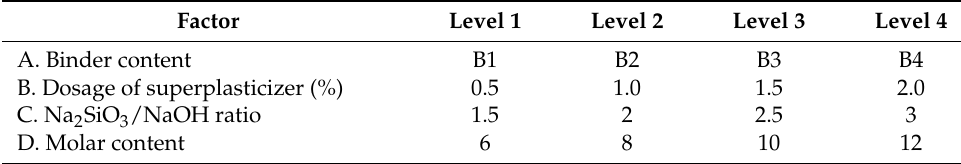
Table 3. Experimental factors and the various levels.